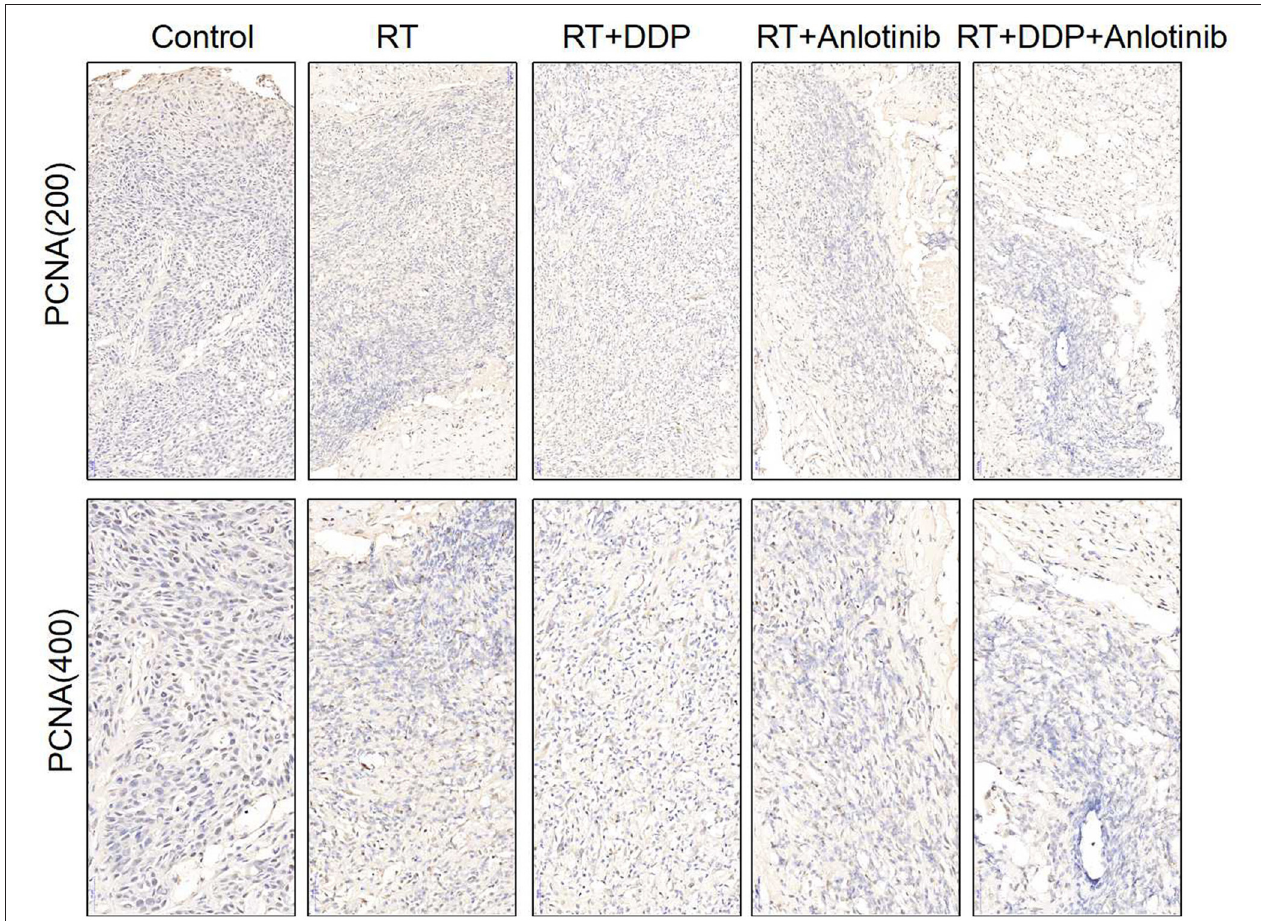
FIGURE 12 | Representative images for proliferation marker of PCNA show that brownish yellow nuclei indicate the positive cells. Various degrees of positive rates were shown in the four treatment groups in which anlotinib combined with chemoradiation-treated group was the lowest compared with control group. The figure provided is a representative image, and other images are provided in the Supplementary Files. RT, radiation therapy; DDP,